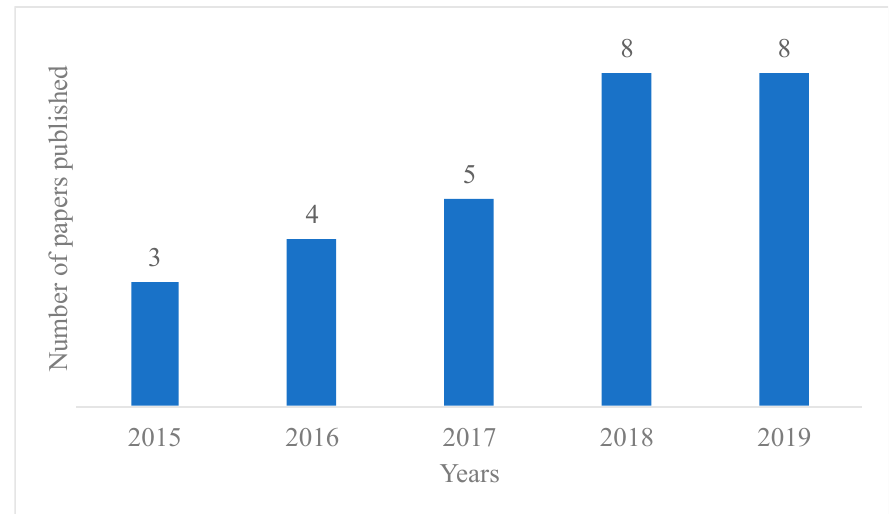
Figure 1. Published papers related to the social aspect of electric vehicles (EVs) (annual publica- tions).